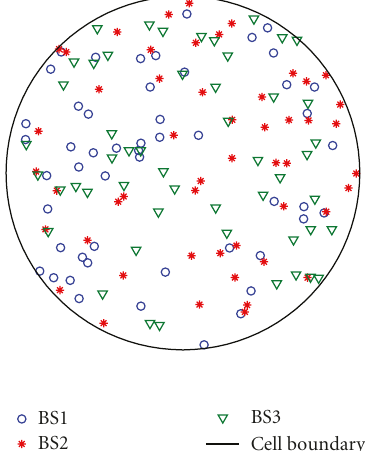
Figure 2: A plot showing a sample distribution of 150 UE, where 50 UEs are assigned to each of the three base stations (BS1, BS2, and